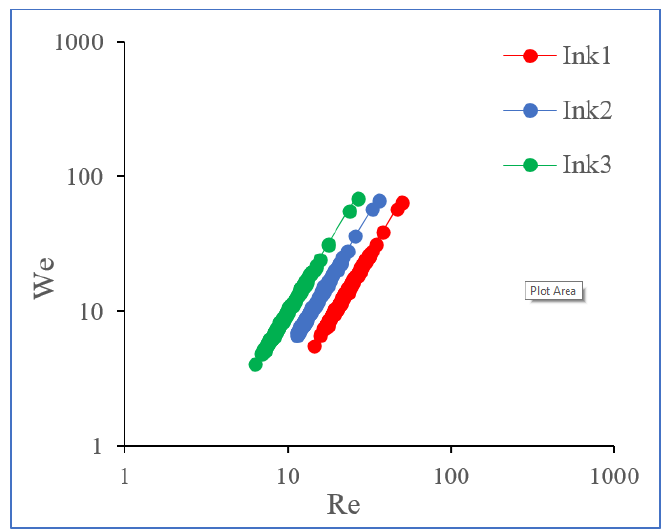
Figure 4. Representation of the Reynolds and Weber numbers, showing the ink properties. Droplet propagation parameters were obtained by COMSOL software. The related graphics can help to understand the behavior and properties of the droplet during ejec- tion, progression in air, and surface interaction, whereby no wettability is considered. Droplet velocity after ejection is not bigger than 10 m/s and compared to Wijshoff [46,47] varies uniformly. Firstly, the droplet velocity during ejection, during the flight, and dur- ing impact is outlined in Figure 5.